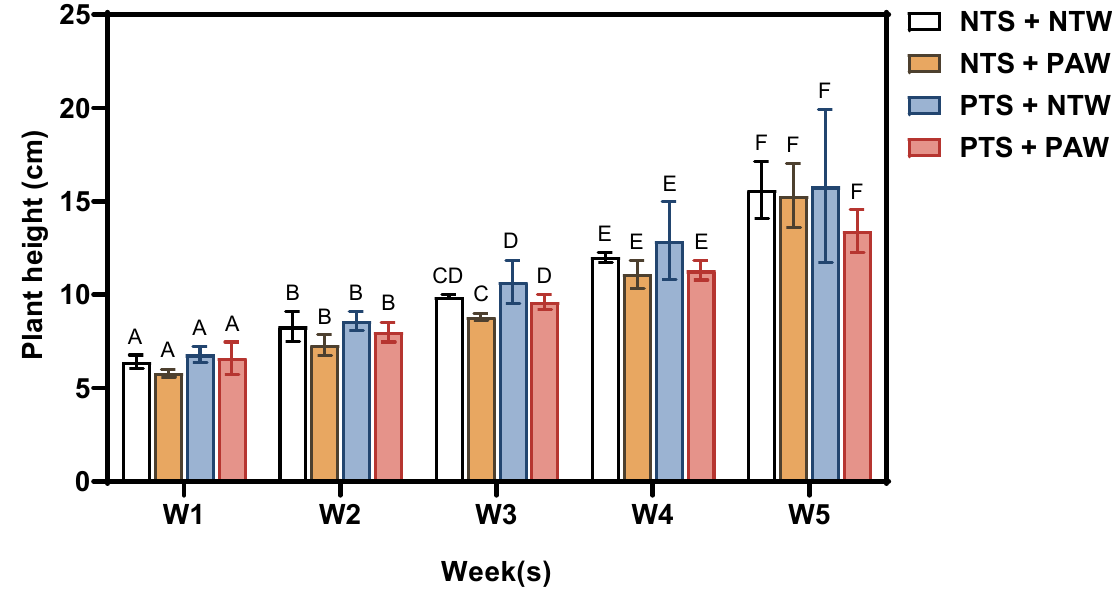
Figure 3. The average height of water spinach in control soil under different treatments. NTS: non-treated seed; NTW: non-treated water; PAW: plasma-activated water; PTS: PAW-treated seed. Different uppercase letters indicate significant difference between groups or treatments, while same uppercase letters do not show significant difference.